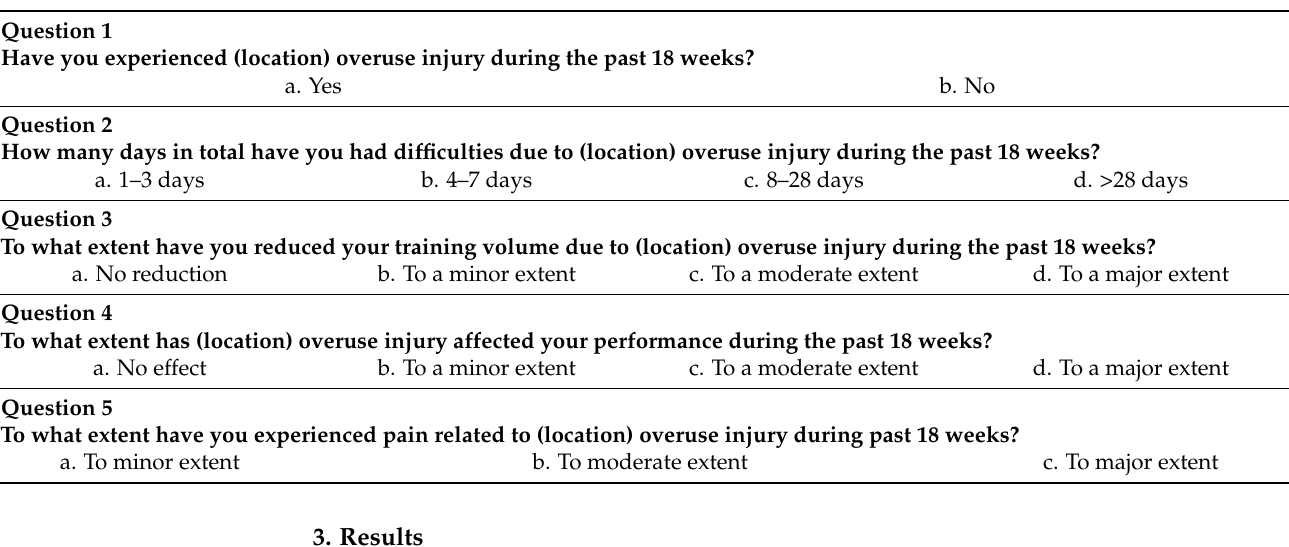
Table 2. Overuse injury survey.